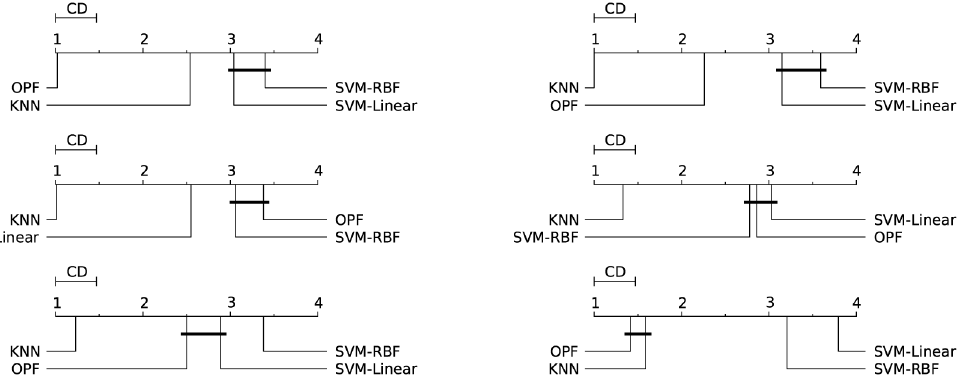
Fig 4. Connect-4. Comparison of all classifiers against each other with the Nemenyi test and learning time constraint equals to 1, 5, 20, 60, 300, and 1200 seconds. Groups of classifiers that are not significantly different (at p = 0.05) are connected.